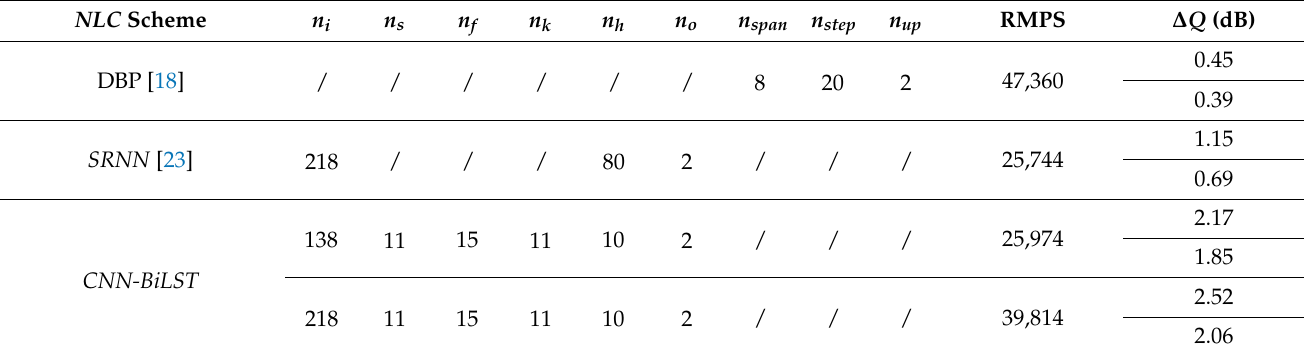
Table 3. Comparison results of the specific complexity of different schemes for experimental system.